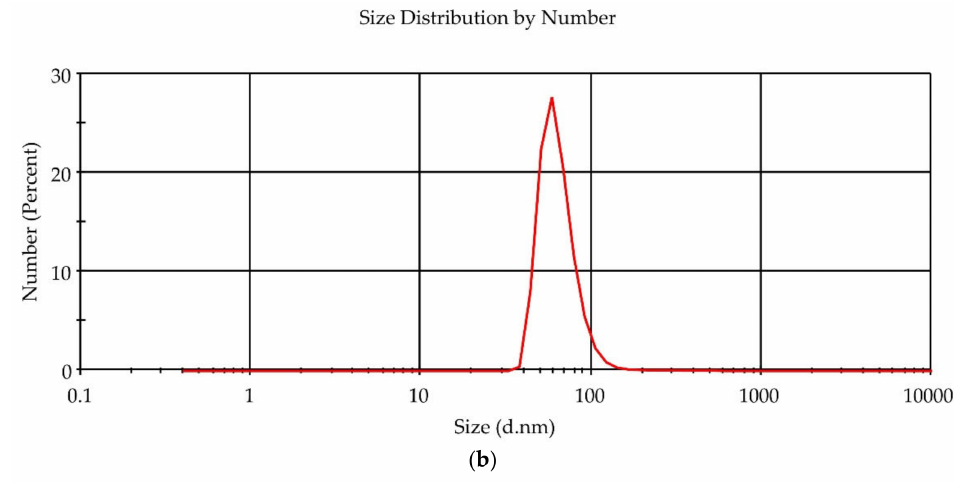
Figure 8. TEM image ( a ) and dynamic light scattering (DLS) of TiO 2 nanoparticles ( b